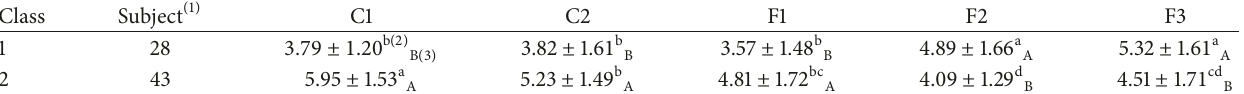
Table 4: Agglomerative hierarchical clustering (AHC) analysis of overall